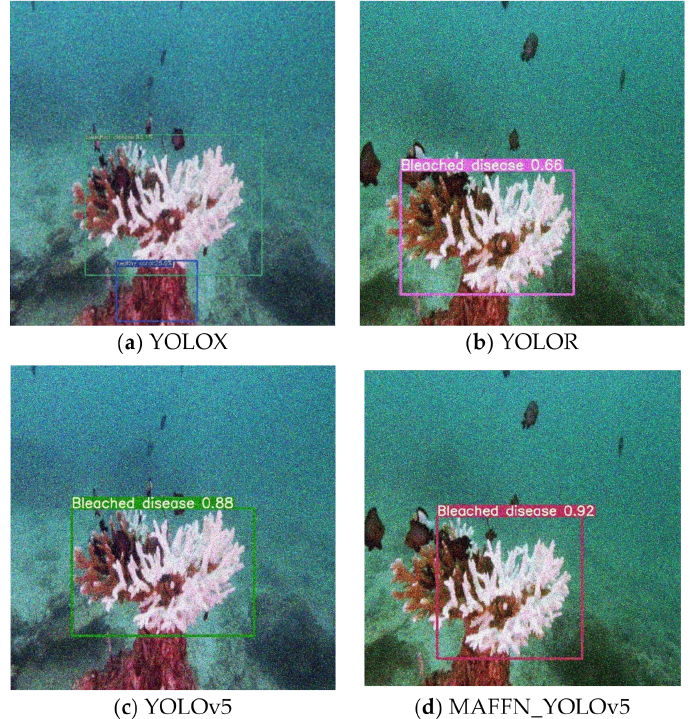
Figure 29. Results of noise-affected bleach disease